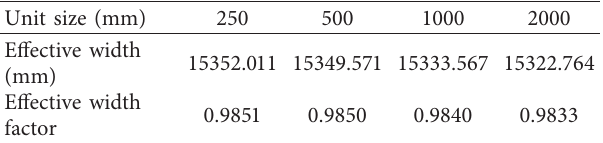
Table 2: Results of the sample bridge with different unit